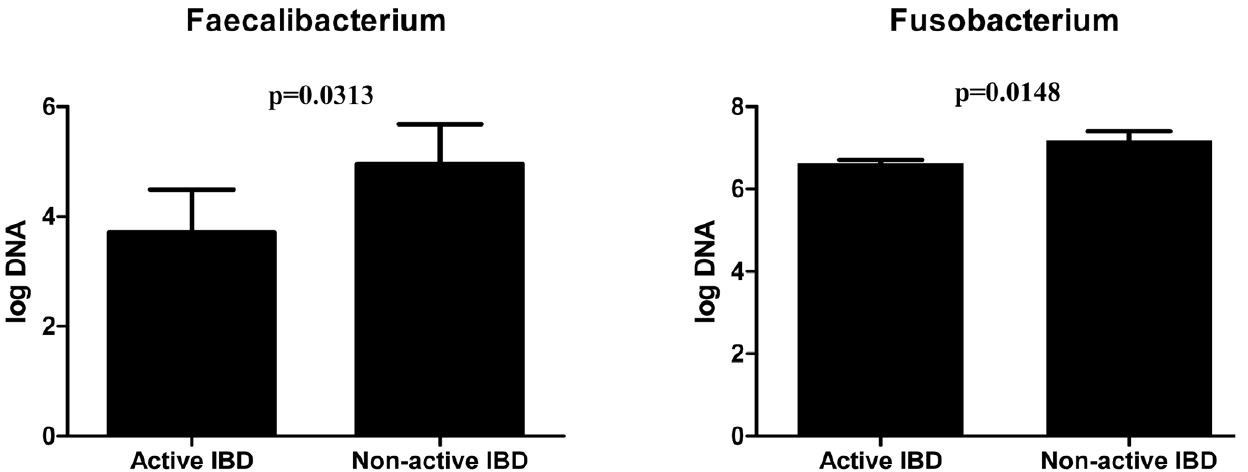
Figure 5. Faecalibacterium spp. and the phylum Fusobacteria in active and non-active IBD. Using qPCR, paired fecal samples were analyzed from dogs (n=8) at time periods of active and clinically insignificant IBD as scored by a clinical IBD disease activity index (CIBDAI). The time period between the collections of repeated samples ranged from 2–8 months (median 5.5 months). None of the other bacterial groups evaluated by qPCR, including total bacteria, revealed significant differences between the paired time